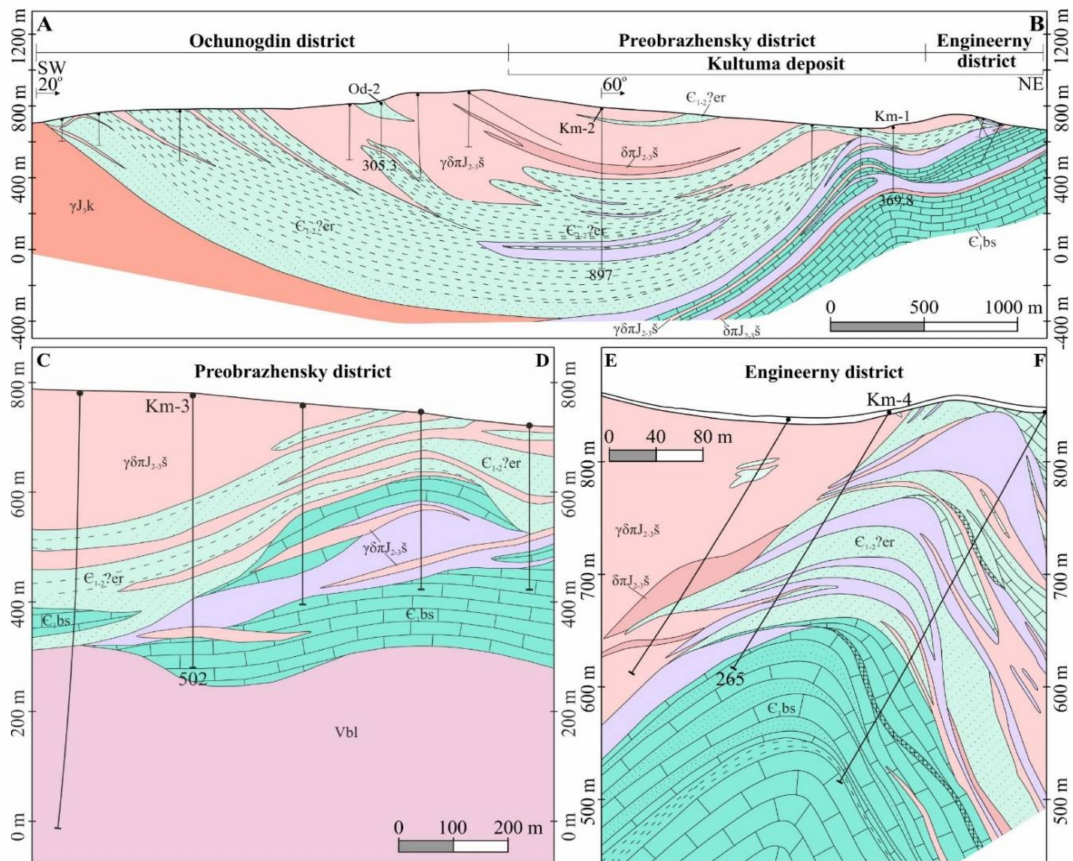
Figure 3. Geological cross-sections of the Kultuma